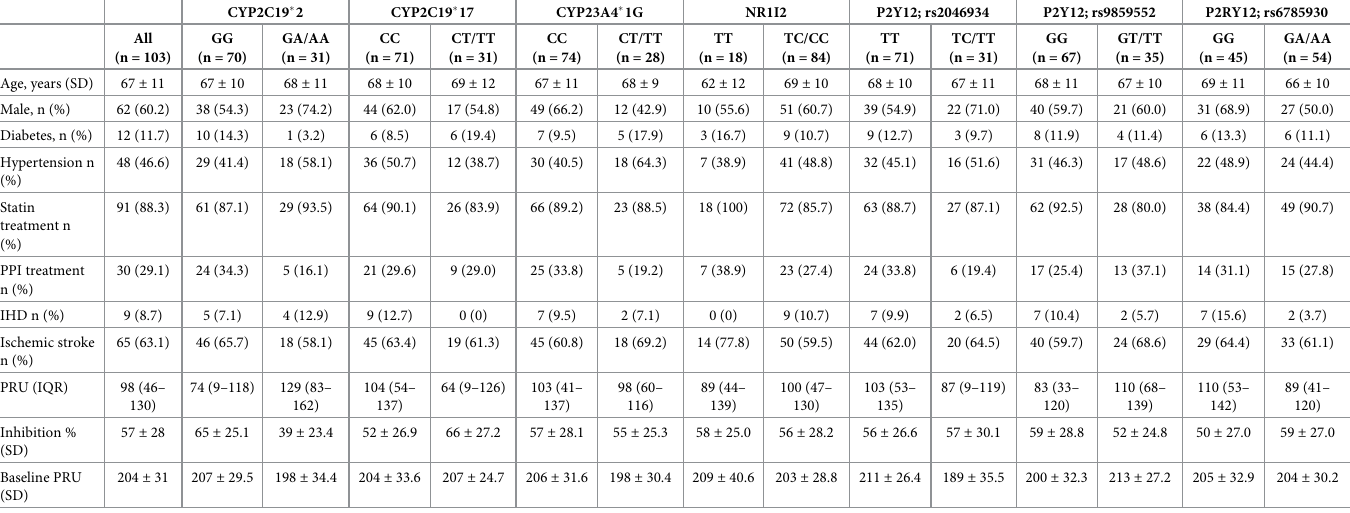
Table 1. Characteristics of the study